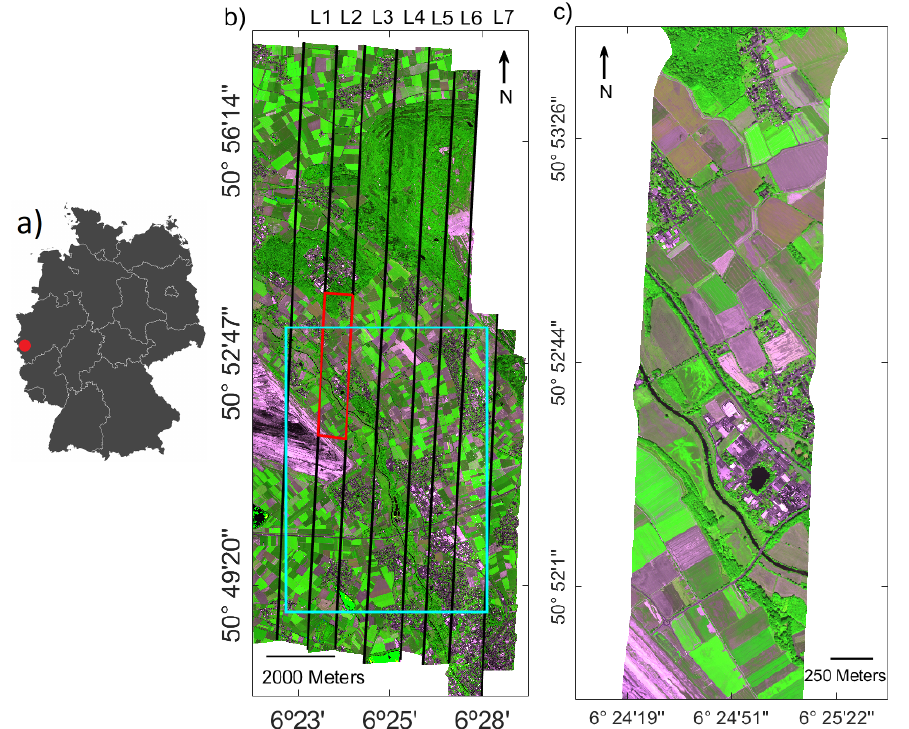
Figure 2. ( a ) Location of the study area in the western part of Germany. ( b ) RGB composite (700.1/754.4/674.4 nm) of the HyPlant FLUO mosaic consisting of seven flight lines (black framed areas) with the subset of flight line L2 used to build the emulator (red framed area). ( c ) Enlarged view of the subset of flight line